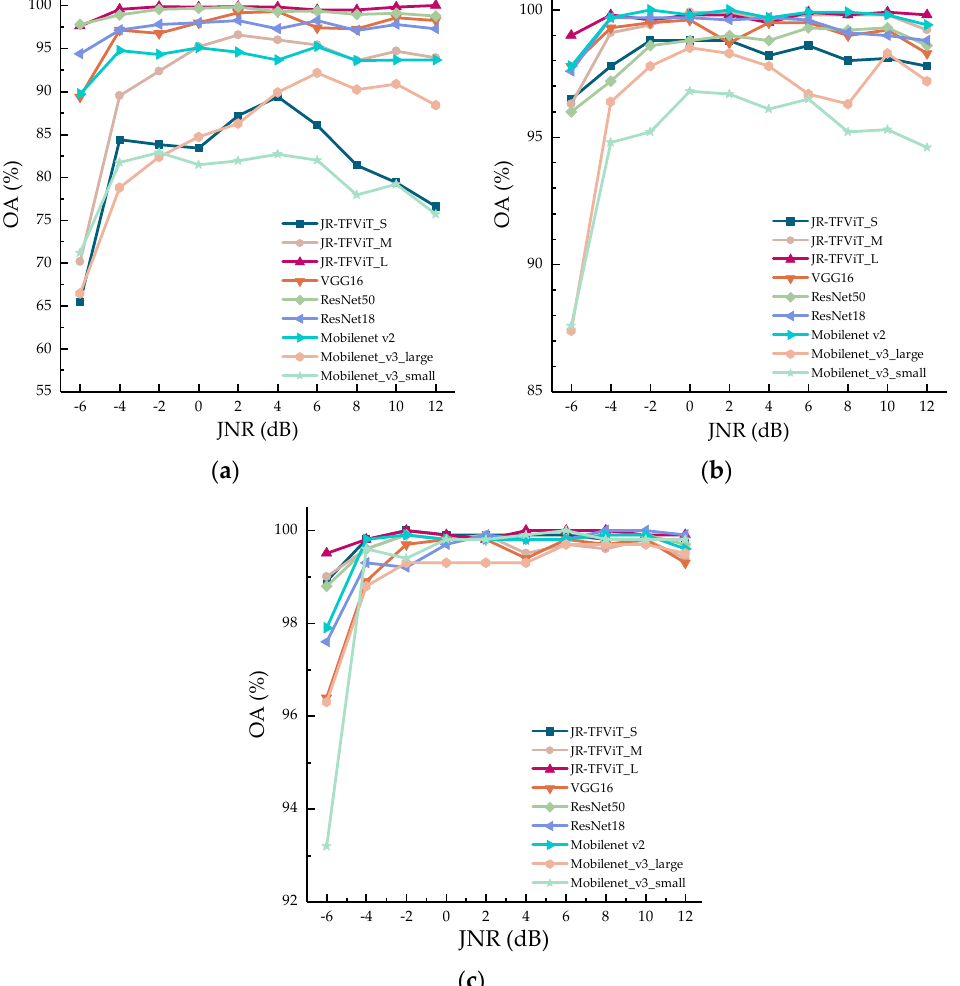
Figure 10. The OA of different recognition networks with different numbers of training samples: ( a ) 50 training samples; ( b ) 75 training samples; ( c ) 100 training samples.